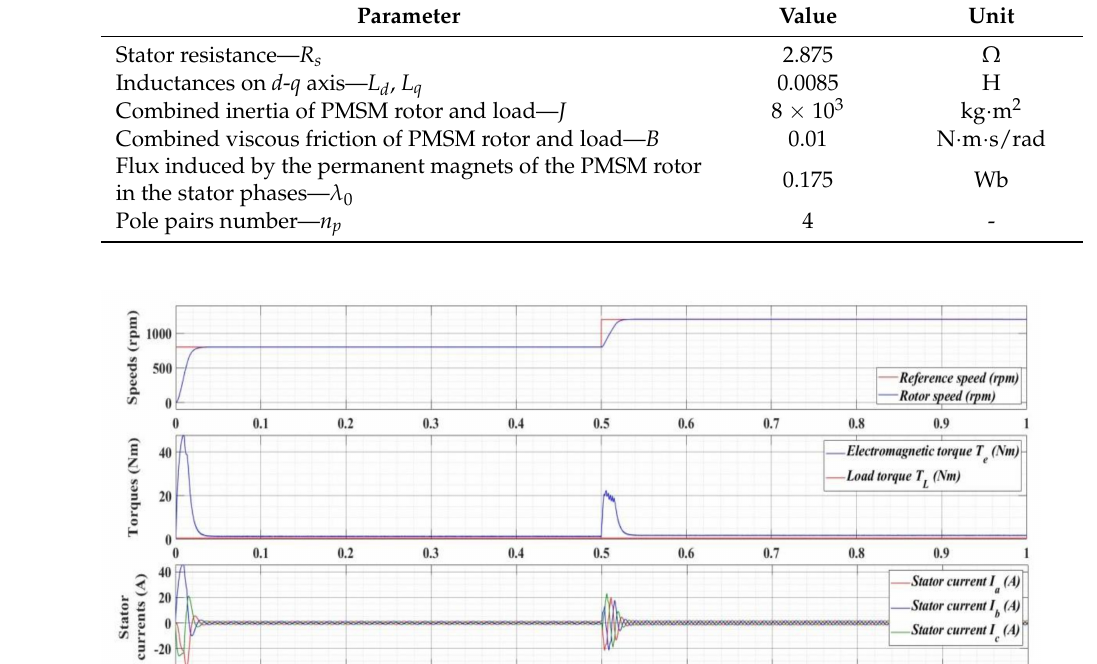
Table 1. PMSM nominal parameters.